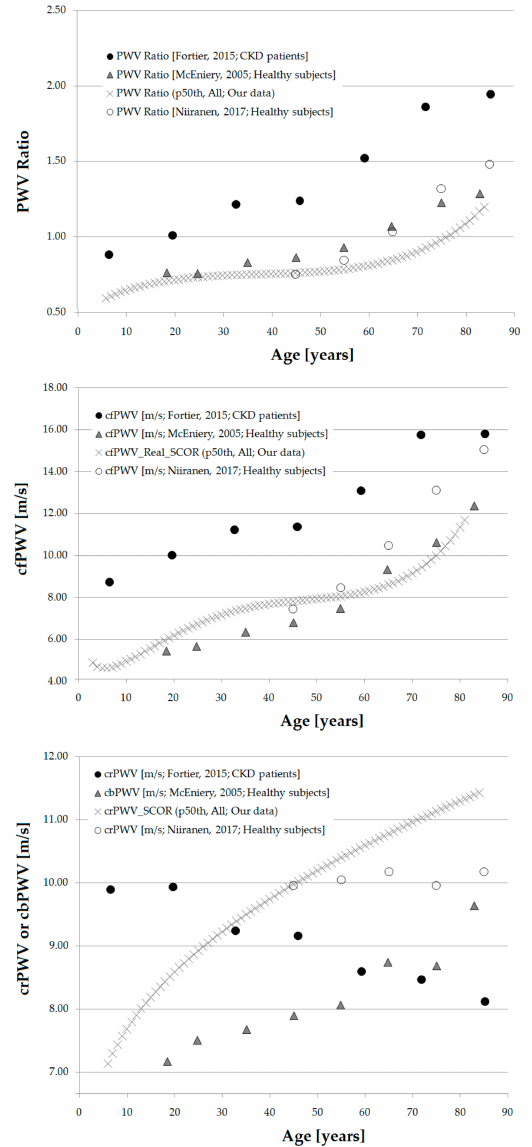
Figure 8. Comparative age-related profiles for PWV Ratio ( Top ), cfPWV ( Middle ) and crPWV or carotid-brachial PWV (cbPWV) ( bottom